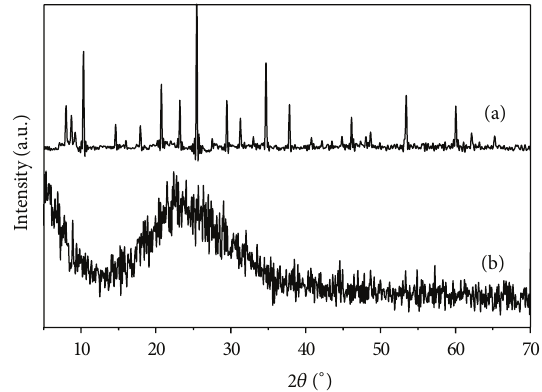
Figure 2: The XRD patterns of H 4 SiW 6 Mo 6 O 40 (a) and H 4 SiW 6 Mo 6 O 40 /SiO 2